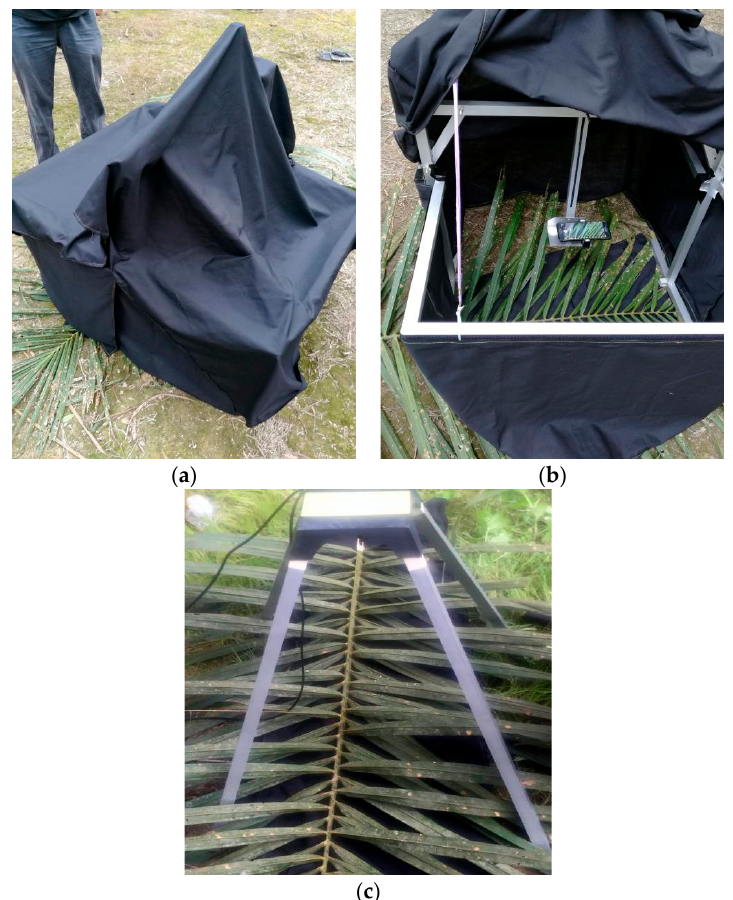
Figure 8. Controlled conditions ( a ) fully closed area, ( b ) half open area, and ( c ) fully open area.